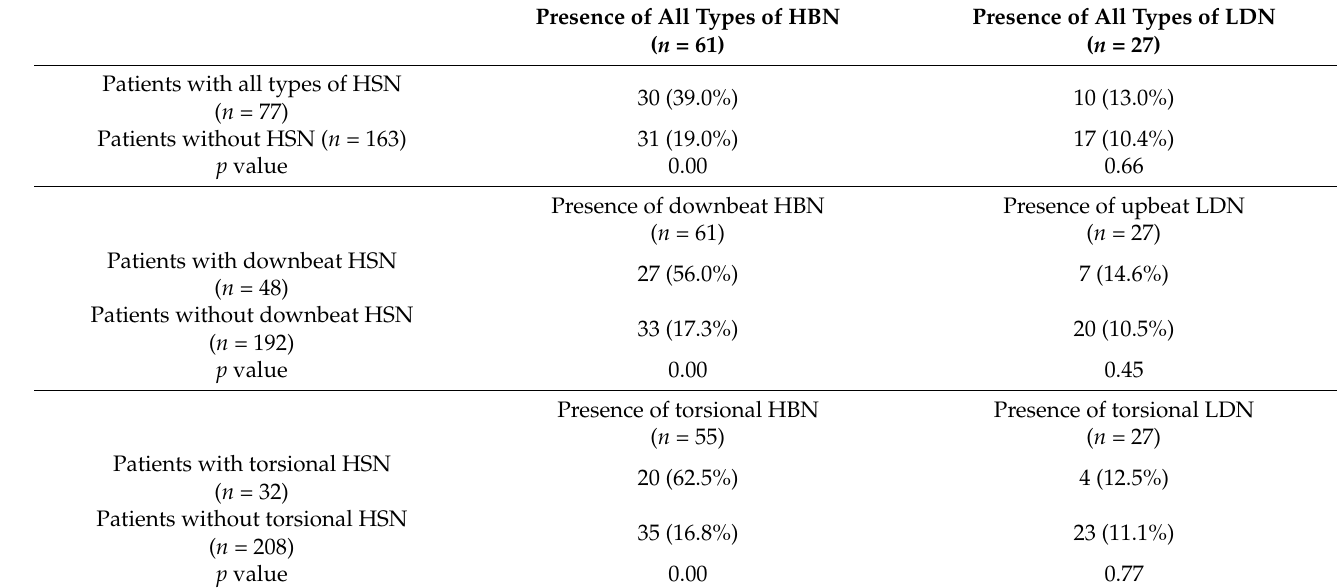
Table 1. Comparison of the presence of HBN and LDN in patients with or without HSN in posterior canal benign paroxysmal positional